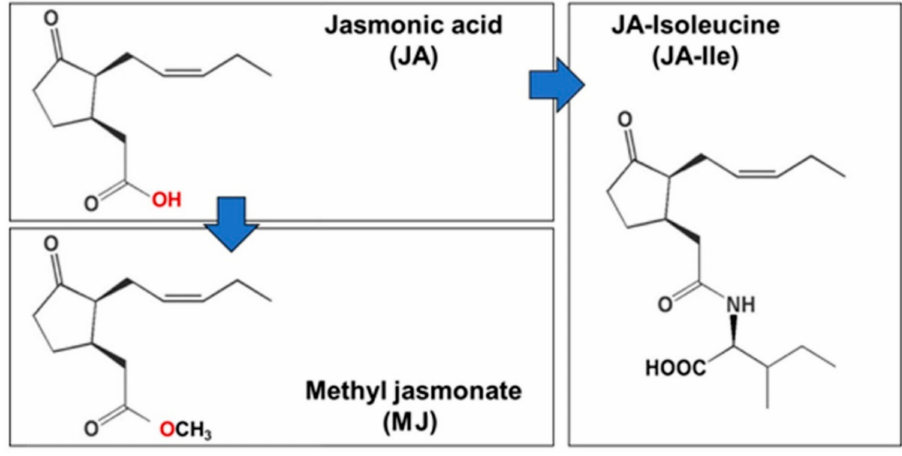
Figure 2. Jasmonic acid and its